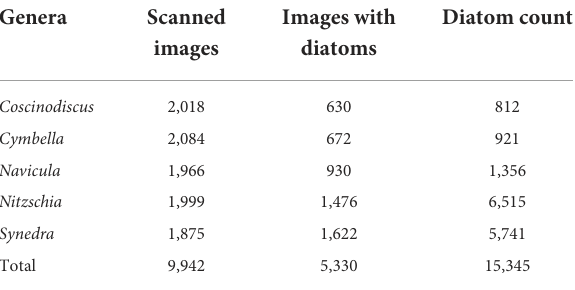
TABLE 1 Summary of the SEM images scanned from the standard samples. Genera